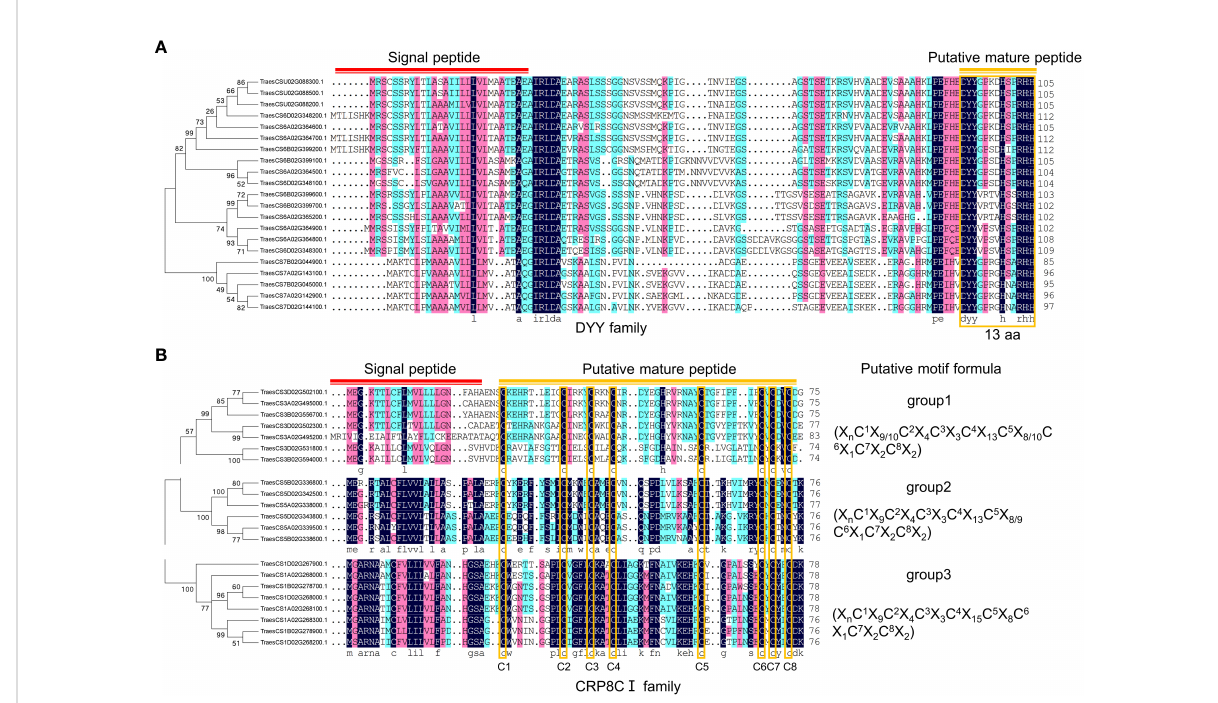
FIGURE 4 Potential novel SSP families in wheat. (A) DYY family consisting of 21 members. Phylogenetic tree was constructed using MEGA 5.0 software, multiple sequences alignment was performed using DNAMAN software. Red line indicates signal peptide, and orange line and box indicate putative mature peptide sequences consisting of 13 amino acids. (B) CRP8CI family, a CRP family consisting of 21 members. Phylogenetic tree was constructed using MEGA 5.0 software, multiple sequences alignment was performed using DNAMAN software. Red line indicates signal peptide, and orange line indicates putative mature peptide sequences containing eight cysteines, which are indicated with orange boxes. The sequences within brackets indicate motif formulas of each group.